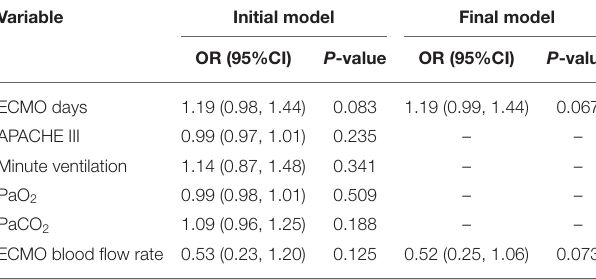
TABLE 4 | Multivariable regression